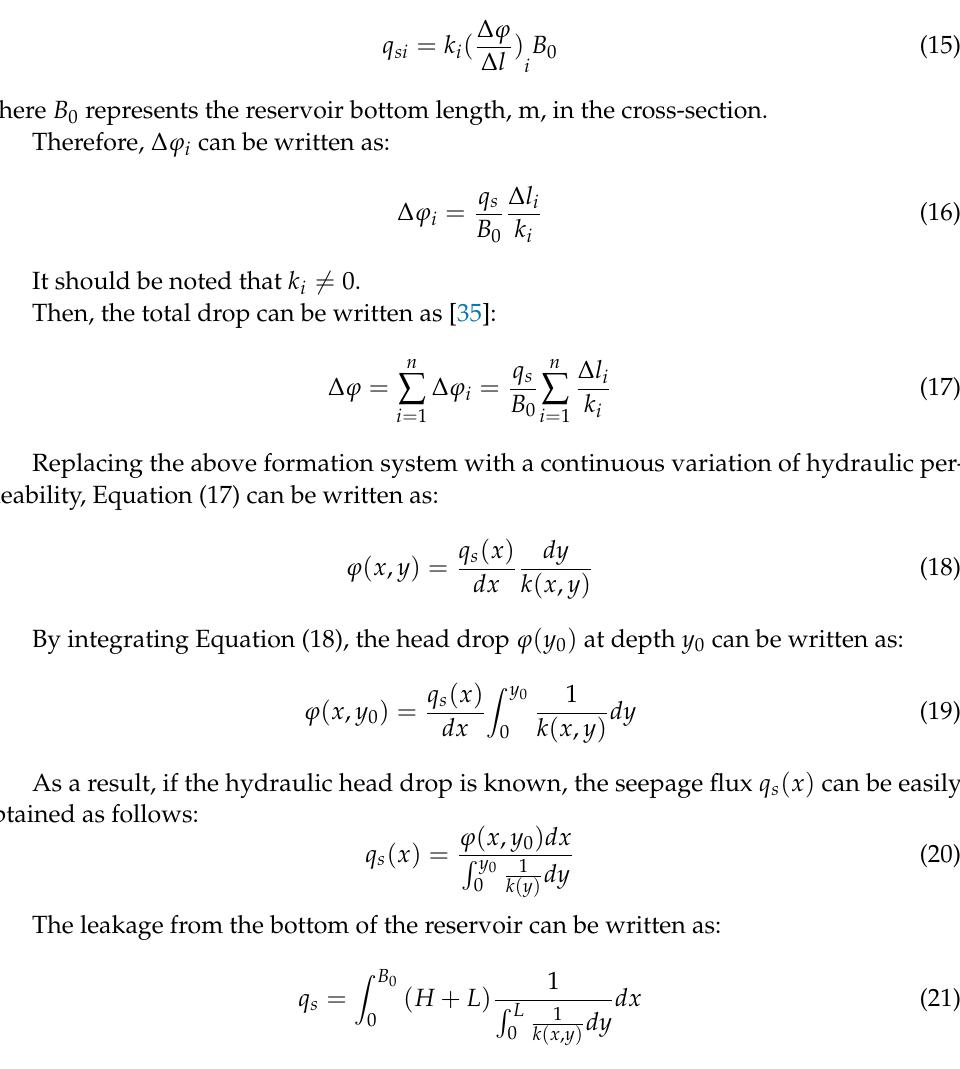
Figure 8. Calculation for leakage from the reservoir bottom. Based on Darcy’s law , the discharge through the reservoir